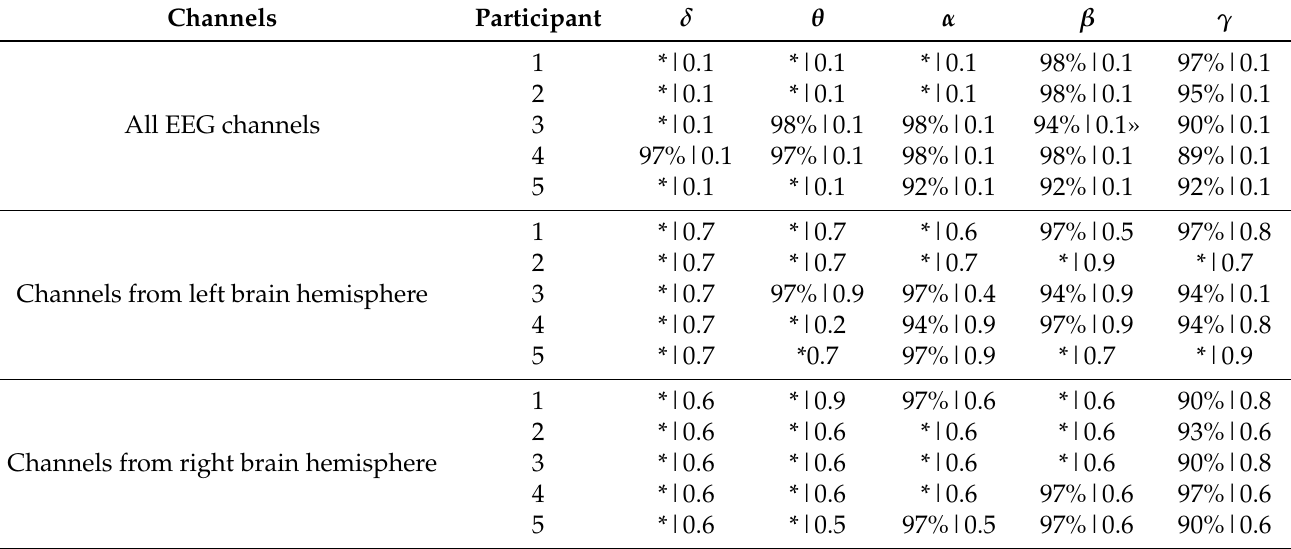
Table 4. The results of classification by the deep learning model for Case Study I for Mona Lisa dataset when we use (first row) all EEG channels, (second row) the channels from only the left hemisphere of the brain and (third row) the channels from only the right one. The first value for each ”cell” (intersection of channels, participant and frequency band) is accuracy (* means 100%), and the second one is the intensity, which gives the maximum influence on the classification.